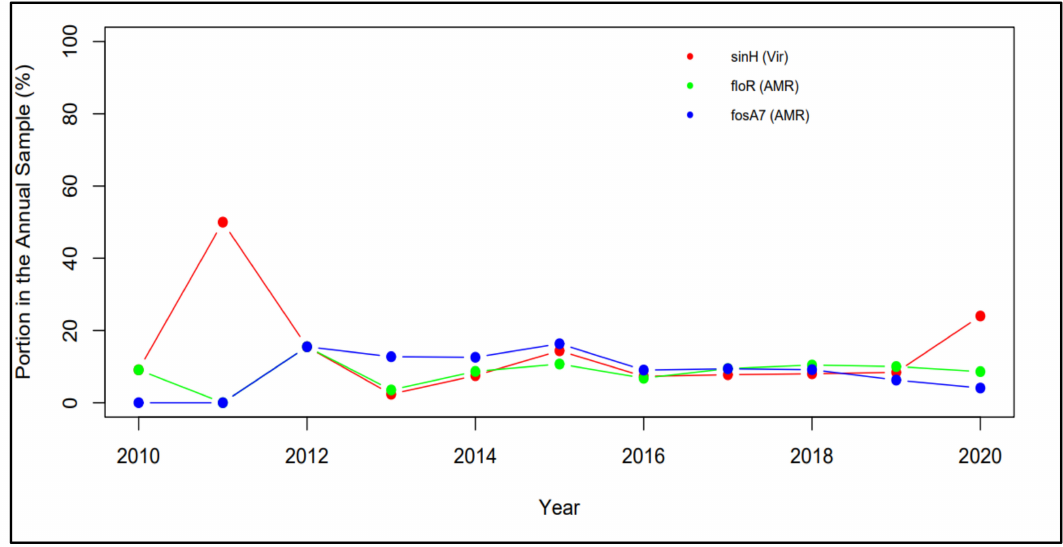
Figure 6. The historical profile of the important virulence and AMR overlap genes in the US in all samples collected from 2010–2020.